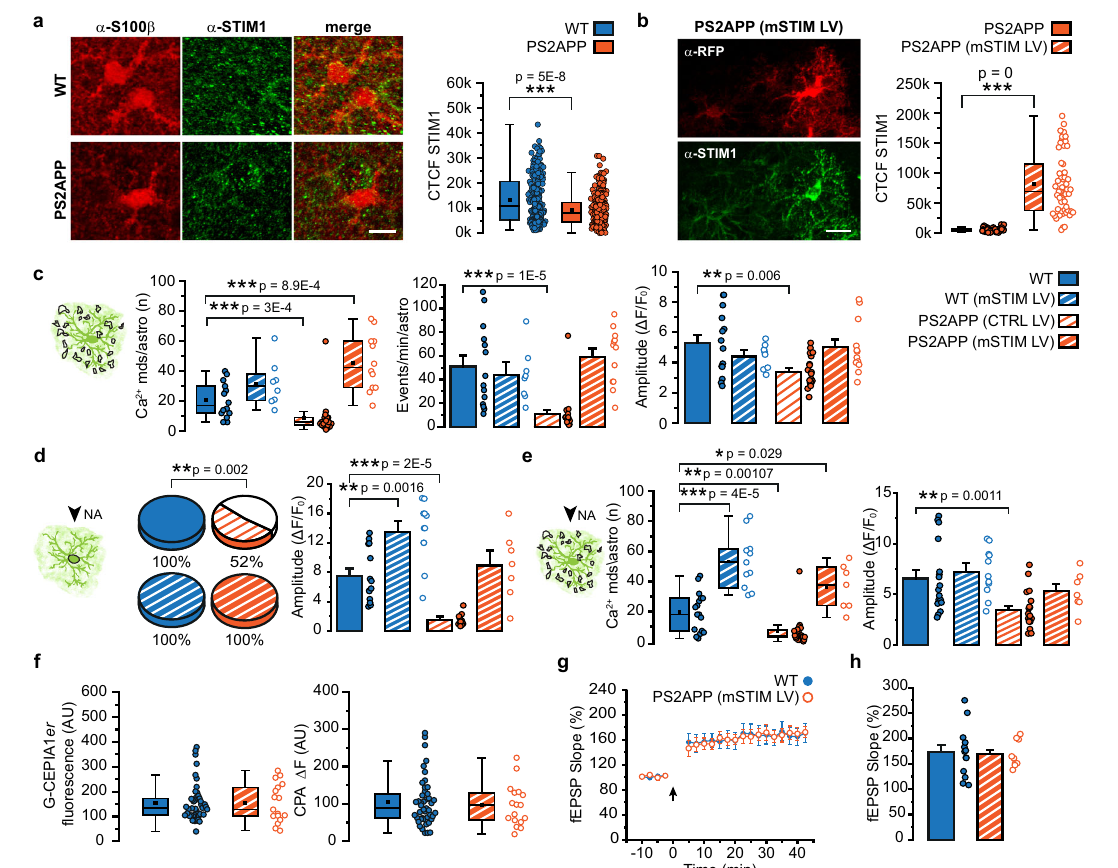
Fig. 6 | STIM1expressioninastrocytesand rescue of Ca 2+ and plasticityde fi cits through astrocytic mSTIM1 overexpression in 6mo PS2APP mice. a Representative immuno fl uorescence signal for STIM1 and S100 β in SSCx slices from 6mo WT and PS2APP mice (max Z -projection of 7 planes, Z -step 1 µ m). Scale bar10 µ m.Right,boxandscatterplotsofcorrectedtotalcell fl uorescence(CTCF)in astrocyticsomata.Boxplotsshowmean,median,25thand75thpercentile,outliers. n =245astrocytesfrom4WT,284astrocytesfrom6PS2APPmice. b Representative immuno fl uorescence signal for STIM1 (green) and tdTomato, stained by α -RFP (red), in SSCx slices from 6mo PS2APP mice injected with mSTIM1 LV (max Z - projection of 9 planes, Z -step 1.5 µ m).Scale bar20 µ m. Right, box and scatter plots of CTCF in astrocytic somata. Box plots show mean, median, 25th and 75th per- centile, outliers. n =53 astrocytes from the injected hemisphere of 2 PS2APP mice and n =107 astrocytes from the non-injected hemisphere of the same mice. c Left, box and scatter plots of the number of spontaneous Ca 2+ mds. Box plots show mean, median, 25th and 75th percentile, outliers. Right, bar histograms (mean± SEM)and scatterplotsreporting the frequencyand theamplitudeofeventsinCa 2+ mds. n =14 astrocytes from 6 WT, 8 astrocytes from 2 WT (mSTIM LV), 20 astro- cytesfrom4PS2APP(CTRLLV)and12astrocytesfrom4PS2APP(mSTIMLV)mice. ForamplitudeandfrequencyonlyastrocyteswithatleastoneactiveCa 2+ mdshave been considered. d Left, pie charts reporting the percentage of NA-responsive